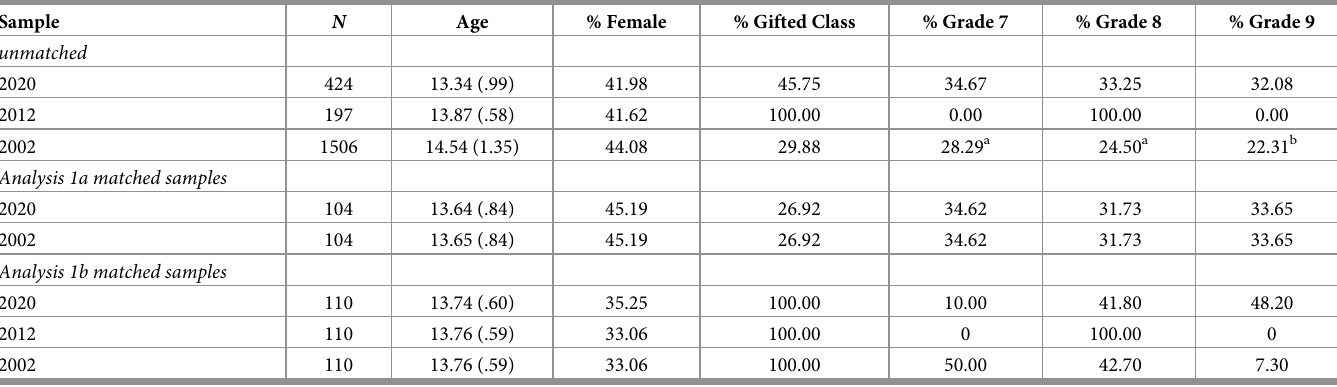
Table 1. Demographic information for the unmatched and matched samples.